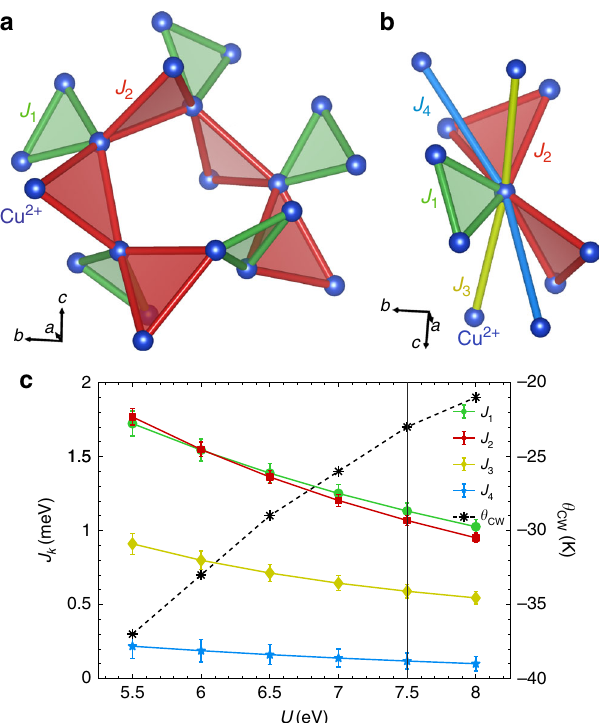
Fig. 1 The magnetic interactions and Hamiltonian of PbCuTe 2 O 6 . a The magnetic structure drawn from the crystallographically equivalent magnetic S ¼ 1 Cu 2 + ions considering only the 1st and 2nd nearest-neighbour 2 interactions J 1 and J 2 respectively. J 1 forms isolated equilateral triangles whereas J 2 leads to a three-dimensional network of corner-sharing triangles also known as the hyperkagome lattice. Here, the triangles on the outer Cu 2 + ions are dropped for simplicity. The 3rd and 4th neighbour couplings J J 2 + ions into 3 and 4 , respectively, are also included in b and couple the Cu chains. The chains formed by J 3 run parallel to the cubic a – c axes while the chains due to J 4 follow the body diagonals. PbCuTe 2 O 6 crystallises in cubic symmetry with space group P4 1 32 and the Cu 2 + ions occupy a single Wyckoff site 26 . The graph in c shows the strengths of the four nearest- neighbour interactions as a function of Cu 2 + onsite interaction U calculated by density functional theory (coloured symbols, left hand axis). These calculations were performed with the full potential local orbital (FPLO) basis set 31 , and the generalised gradient approximation functional 42 ; the coupling constants were then determined by fi tting to the Hamiltonian in Eq. (1). The error bars indicate statistical errors of the fi t. The Curie- Weiss temperature was calculated for each set of exchange constants P 4 ¼ (cid:3) S ð S þ 1 Þ z J z k using θ k k (for single-counting of bonds) where k ¼ 1 CW 3 k b is the coordination number of the J th k interaction (black stars, right hand axis). All the interactions are antiferromagnetic and they have the ratio J : J : J : J (cid:4) 1 : 1 : 0 : 5 : 0 : 1. J J 1 and 2 are approximately equal, and much 1 2 3 4 stronger than J 3 and J 4 . Together, J 1 and J 2 result in the hyper-hyperkagome lattice where each magnetic ion participates in three corner-sharing triangles forming closed loops of 4 spins and 6 spins (compared to two triangles and 10-spin loops in the hyperkagome